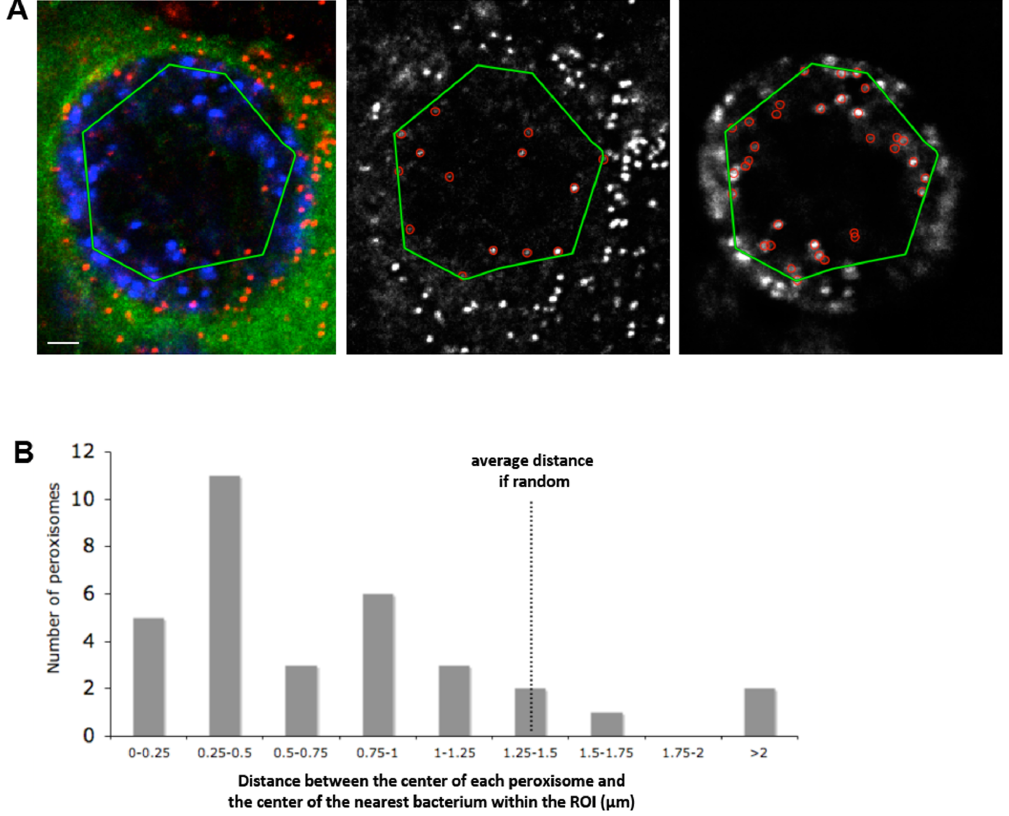
Figure 2. Peroxisomes are close to bacteria. A- Quantitative image analysis. A green polygon representing the Region Of Interest (ROI) was drawn over an optical section from the stack of images shown in Movie S1 (left image): bacteria are in blue, peroxisomes in red, GFP in green. Peroxisomes and bacteria detected within the ROI are circled in the middle and right images, respectively. Scale bar: 2 m m. B- Quantification of the distances between intra-inclusion peroxisomes and bacteria. The minimal distances between peroxisomes and bacteria within the ROI were calculated (from three different cells with respectively 6, 13 and 14 peroxisomes each, n=33 peroxisomes in total) and the distribution of these distances is shown in the histogram. We calculated (see Methods) that a random distribution of bacteria and peroxisomes within the ROI would result in an average distance of 1.35 m m (p=0.05, dotted line). The observed distribution is strongly shifted to the left and supports the hypothesis of a contact, or close proximity, between intra-inclusion peroxisomes and bacteria.